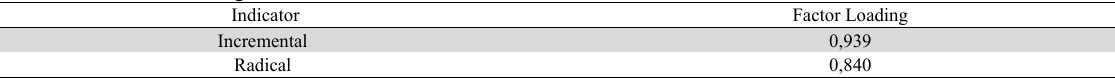
Innovation Variable Loading Factor Test Results